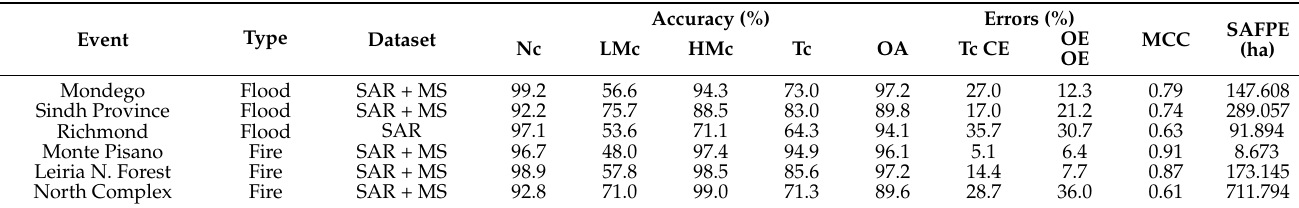
Table 13. Summary of the fusion data results (if available) for each case study (Nc—no